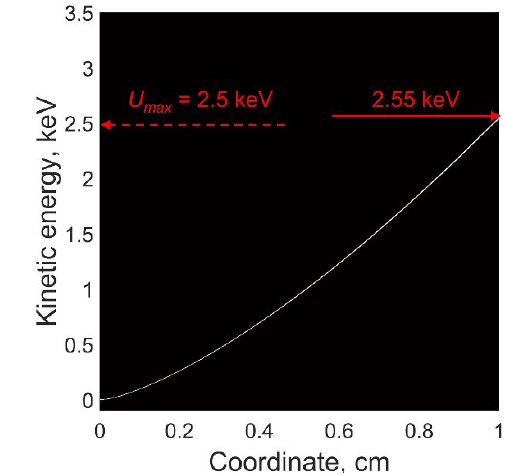
Figure 4 – Electron distribution function density plot at 1.5